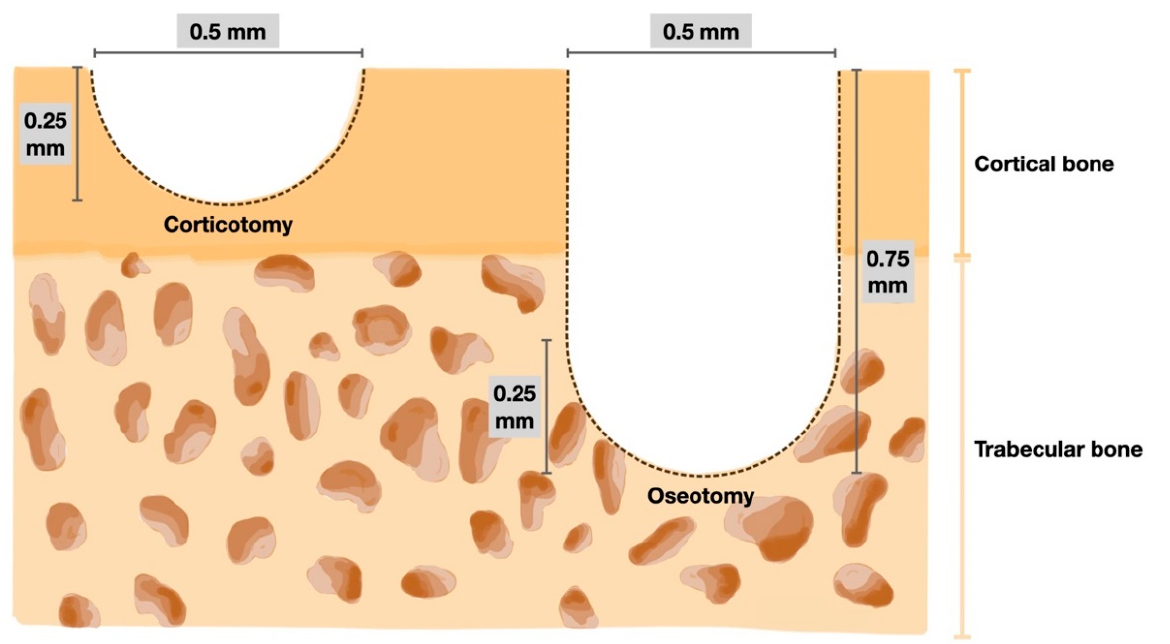
Figure 3. Diagram of the bone perforation for corticotomy ( left ) and osteotomy ( right ).